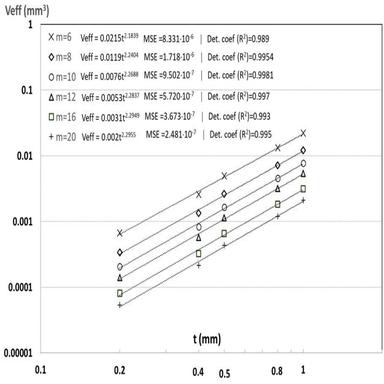
Variation of the effective volume, Veff, calculated by FEM, with the specimen thickness, t, for different values of the Weibull modulus, m (log-log coordinates).